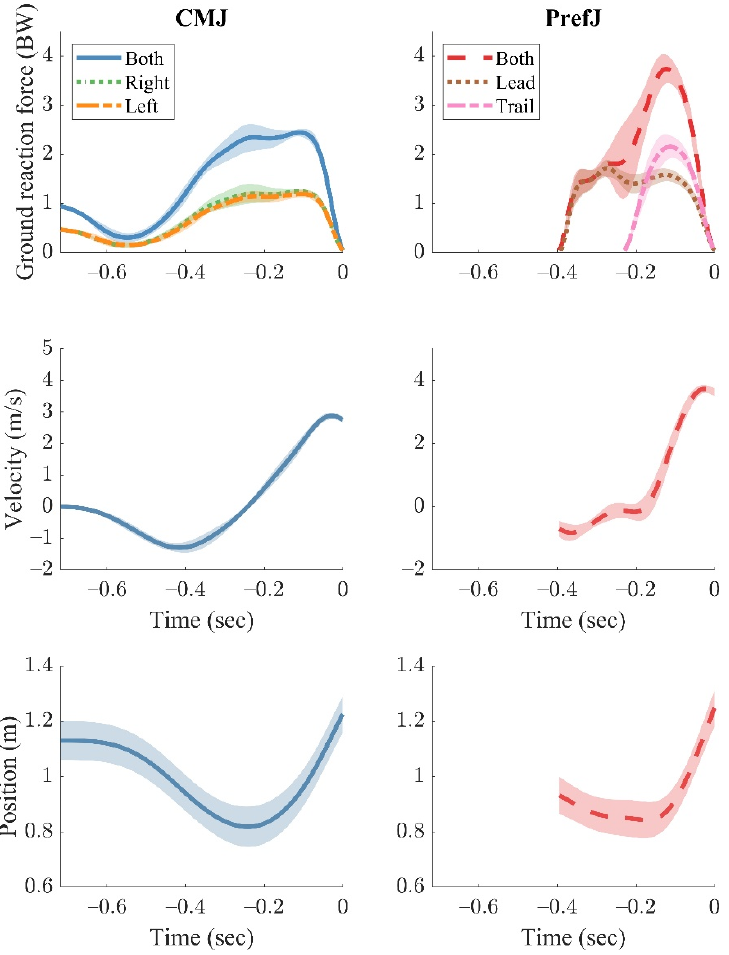
Figure 2. Ensemble average of the ground reaction force ( top row ), vertical pelvis velocities ( middle row ), and vertical pelvis position ( bottom row ) during the countermovement jump (CMJ: Left column ) and preferred-style jump (PrefJ: Right column ).